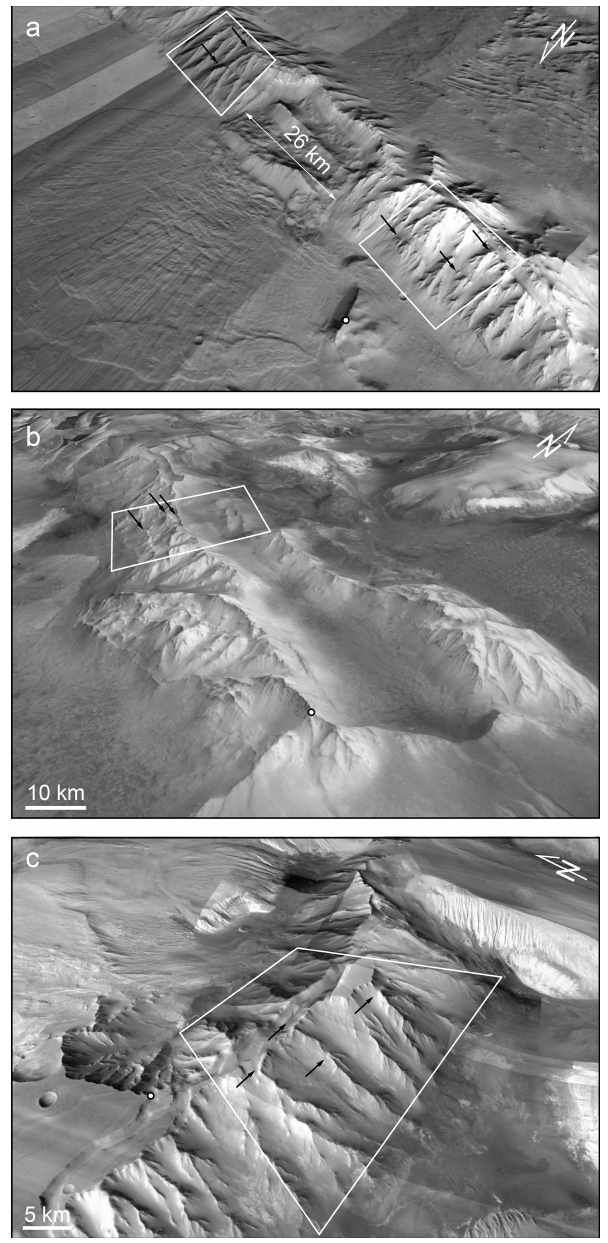
Figure 3. Martian study sites. White dot indicates landmark for easier site localisation, with coordinates in the Mars sphere da- tum. (a) Site M1: Coprates Montes. DSGSD is observed on the ridge on both sides of the landslide. Landmark is at 11 ◦ 52 (cid:48) 29 . 3 (cid:48)(cid:48) S, 68 ◦ 19 (cid:48) 44 . 1 (cid:48)(cid:48) W. (b) Site M2: Melas–Candor boundary ridge. Land- mark is at 8 ◦ 29 (cid:48) 4 . 9 (cid:48)(cid:48) S, 72 ◦ 36 (cid:48) 25 . 1 (cid:48)(cid:48) W. (c) Site M3: Candor–Ophir boundary ridge. Landmark is at 4 ◦ 46 (cid:48) 33 . 6 (cid:48)(cid:48) S, 73 ◦ 45 (cid:48) 57 . 8 (cid:48)(cid:48) W. The boxes locates the areas where the profiles were measured (Fig. 6). Arrows indicate DSGSD scarps. MRO–CTX mosaic draped on Mars Express/HRSC topography.